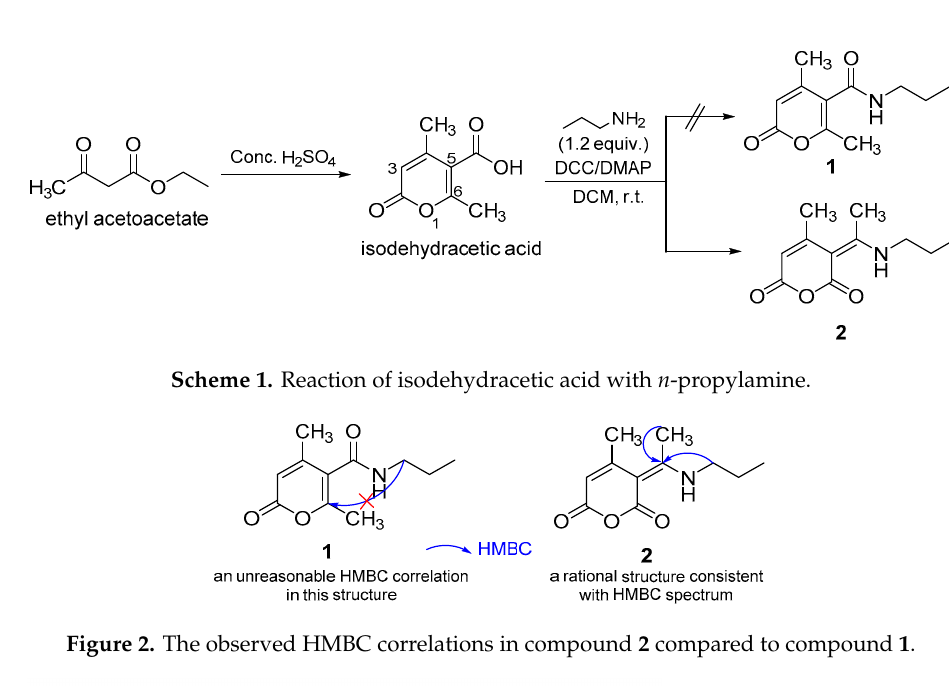
Figure 1. Synthetic pathways to different typical β -enaminones ( a [13–16], b [13,14], and c [17–19]) and the synthesized structure ( IV ) in present work.